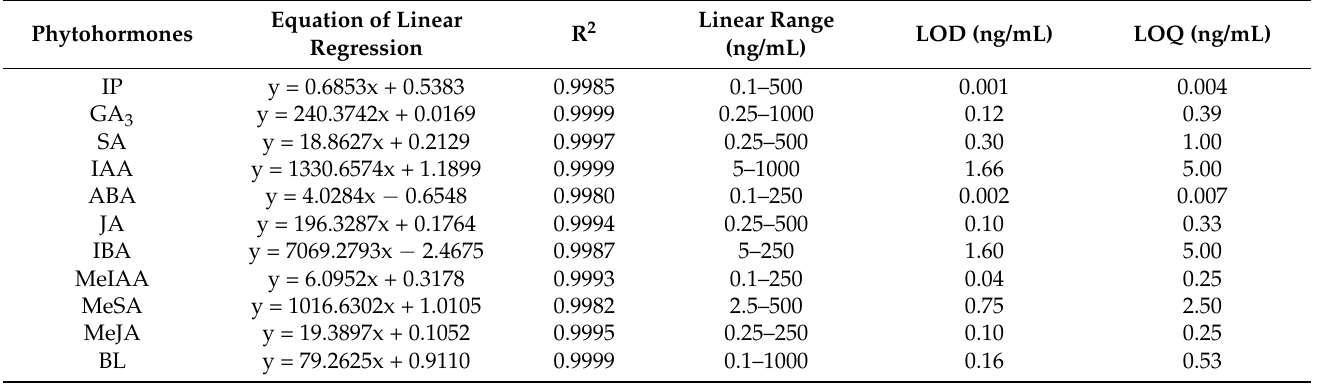
Table 4. The calibration equations, linearly dependent coefficient (R 2 ), linear range, limit of detection (LOD) and limit of quantization (LOQ) for 11 phytohormones.